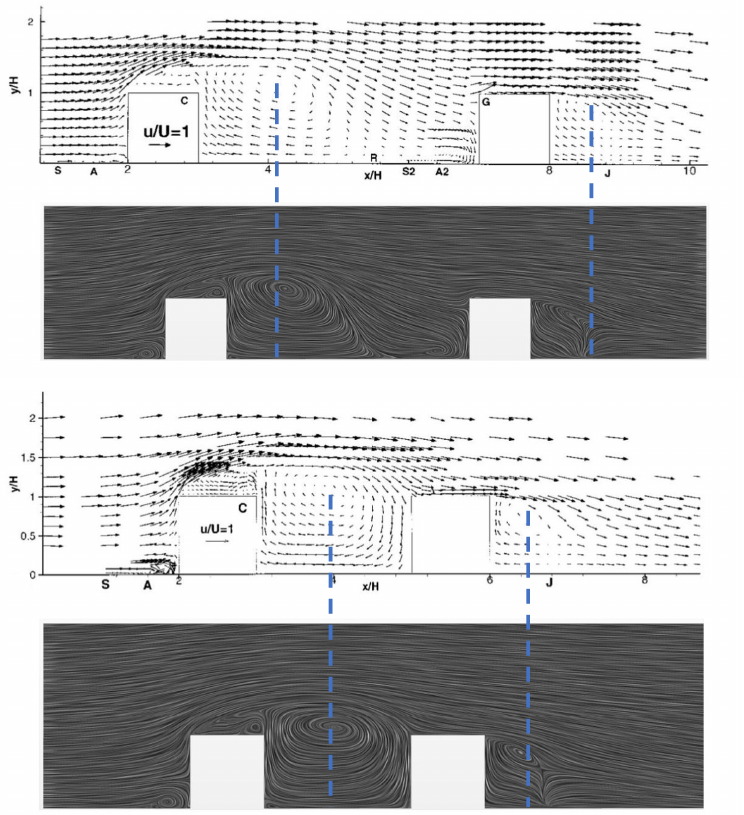
Figure 11. Mean Velocity Vector Field along Symmetry Plane with vortex core positions highlighted by dashed lines. Top— x / h = 4 and Bottom—- x / h =